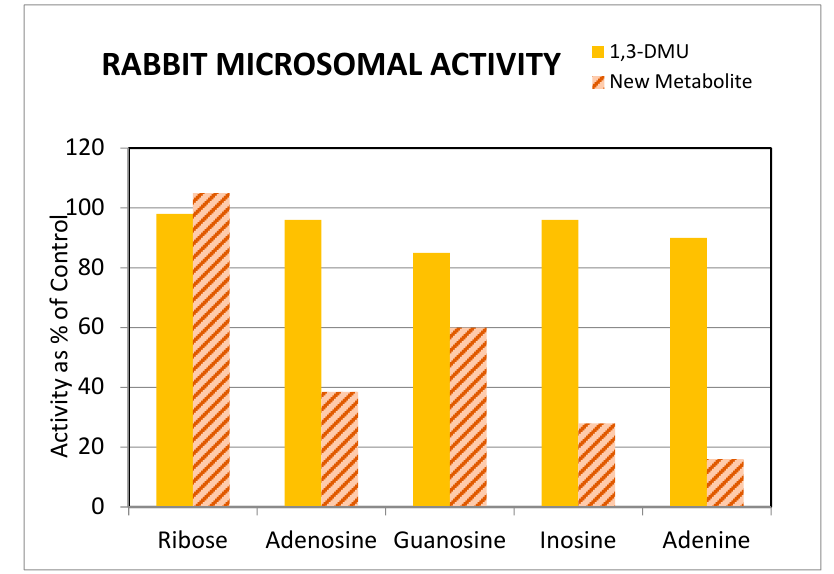
Figure 5. Inhibition of theonosine production by purinergic nucleosides in rabbit lung microsomes.